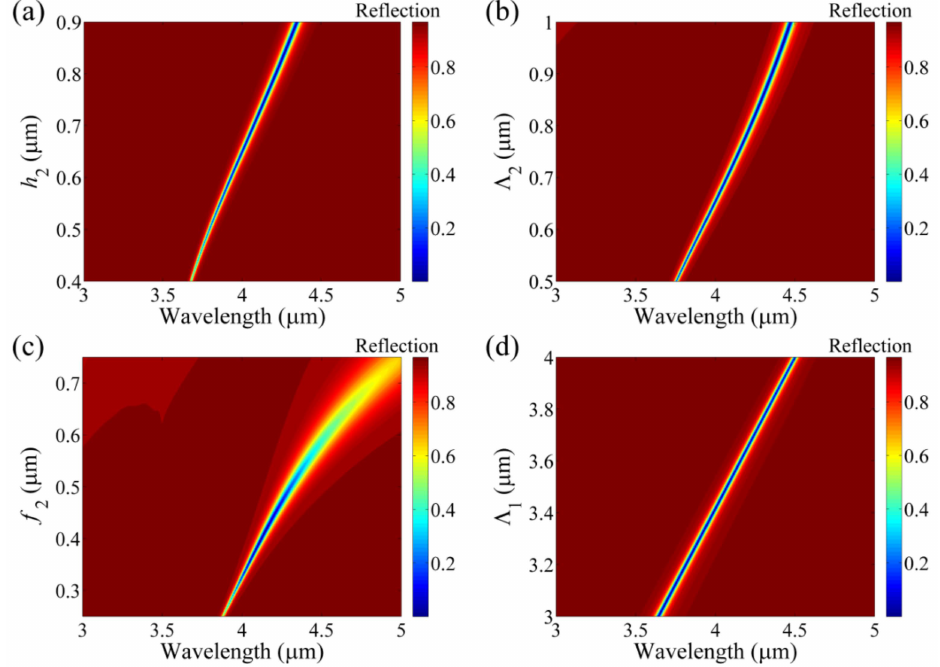
Figure 4. Reflection as a function of ( a ) the grating height h 2 , ( b ) the sub-period Λ 2 , ( c ) the sub-filling-factor f 2 , and ( d ) the structure period Λ 1 . In ( d ), Λ 2 is also adjusted to keep 2 Λ 2 / Λ 1